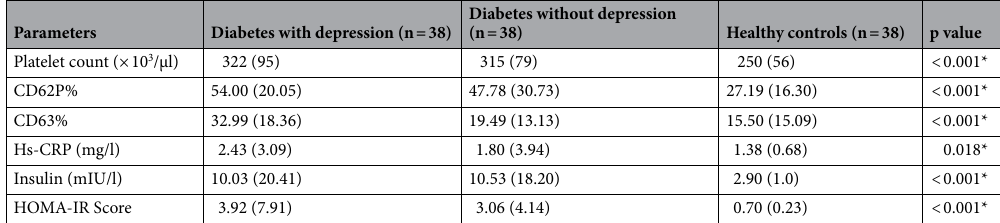
Table 2. Comparison of platelet parameters, hs-CRP, fasting insulin and HOMA-IR Score between the study groups. Results represented as Median (IQR). p value calculated by Kruskal–Wallis H test. *p value < 0.05, shows statistically significant